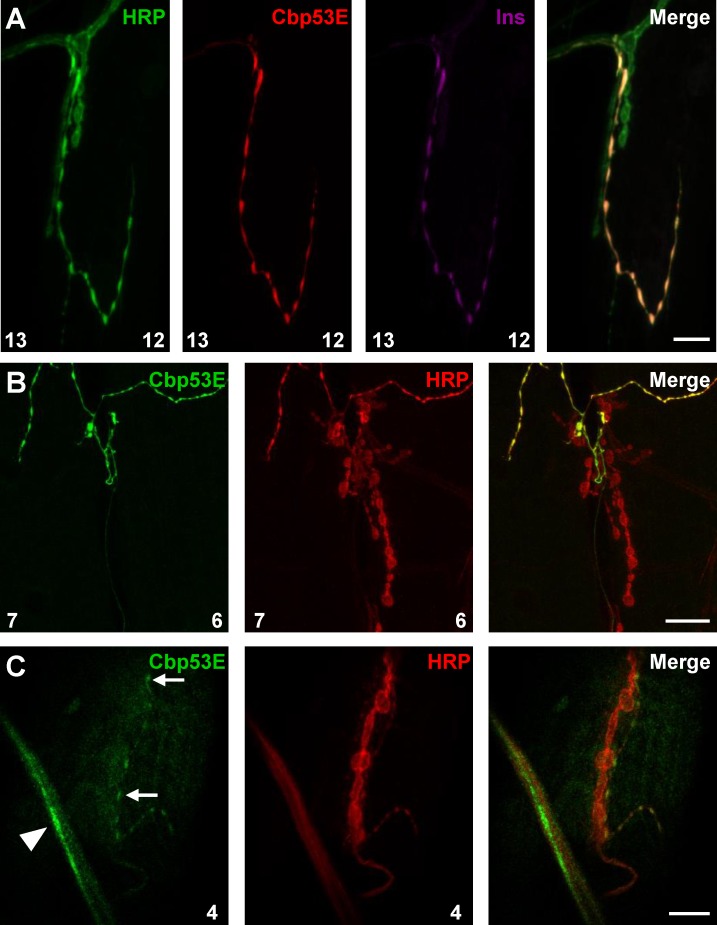
Expression of Cbp53E at the larval neuromuscular junction.A) Insulin peptide (purple) and Cbp53E (red) co-label type III boutons on muscle 12 of the NMJ. HRP (green) labels all neurons. B) A representative maximum intensity projection of strong Cbp53E staining (green) in type II boutons on muscles 6/7. C) A representative single slice image of weak Cbp53E staining (green) in type II boutons (arrow) on muscle 4. Cbp53E can also be seen in the nerve fibers around most muscles (arrowhead). Scale bars in all panels are 20μm.